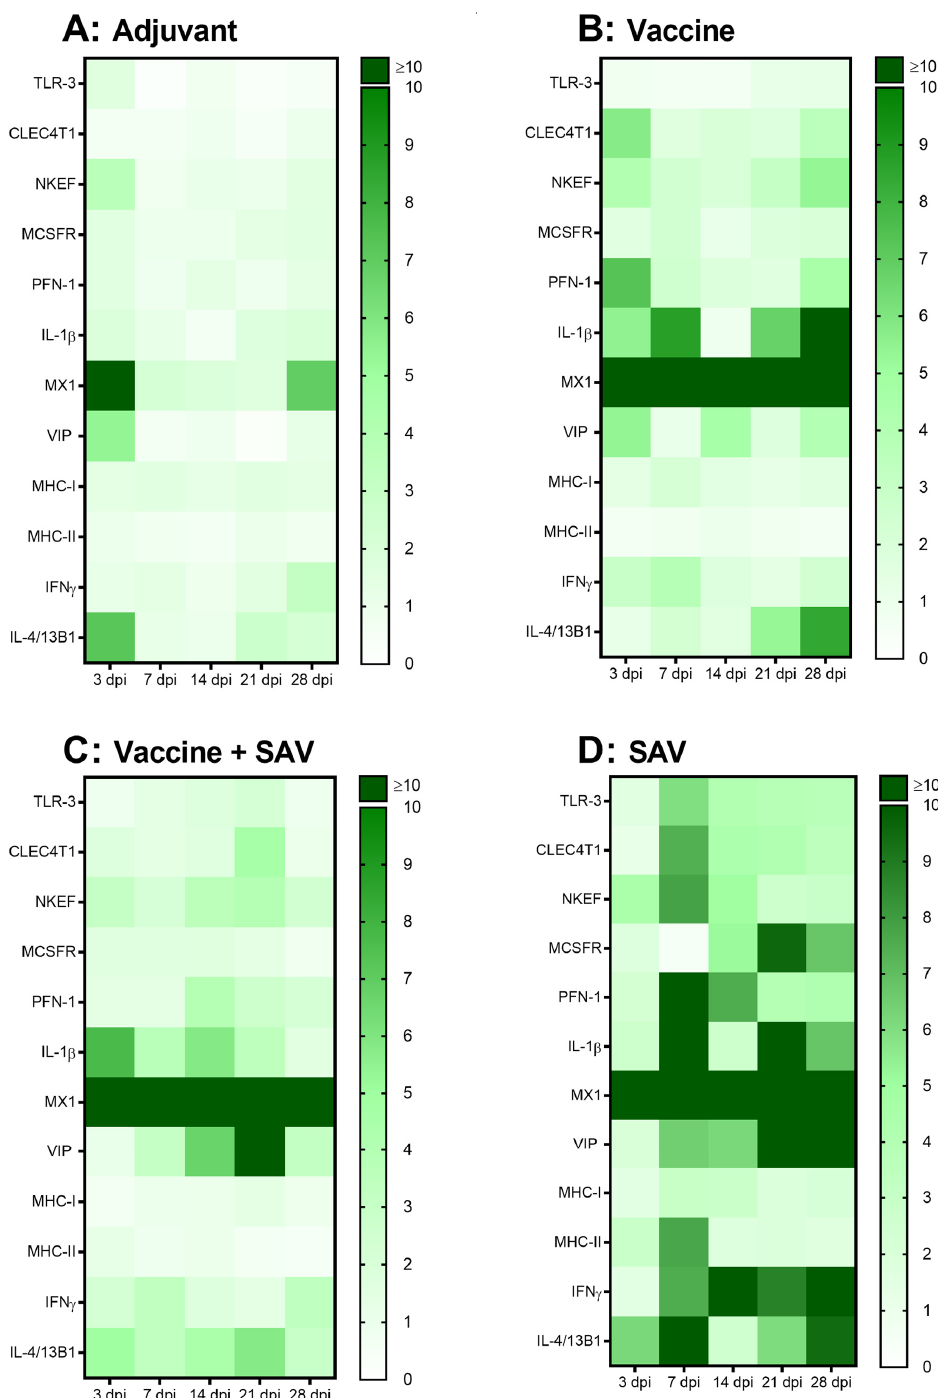
Figure 4. Heatmaps of RT-qPCR data showing gene expression (mean fold change, n = 4 / treatment group / time point) in PBLs at 3, 7, 14, 21, and 28 days post injection with ( A ) adjuvant, ( B ) vaccine, ( C ) SAV challenge following vaccination, and ( D ) SAV challenge. All gene values were normalized against a housekeeping gene EF-1 α followed by normalization against the average values of control group